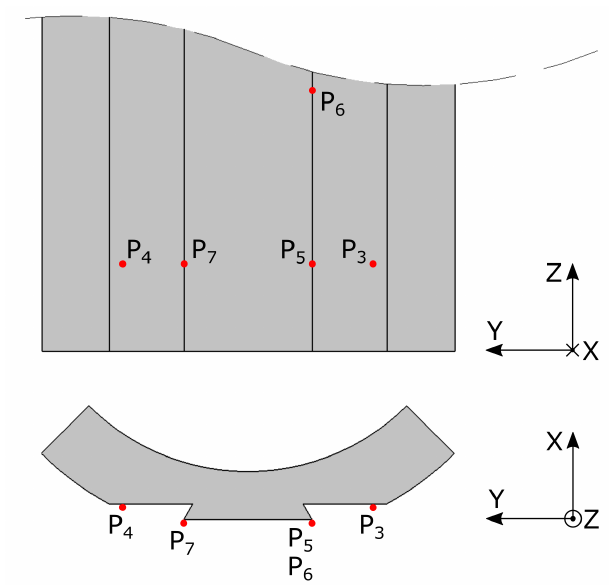
Figure 7. Position of points and coordinate system alignment, projected on a section cut-out of the central